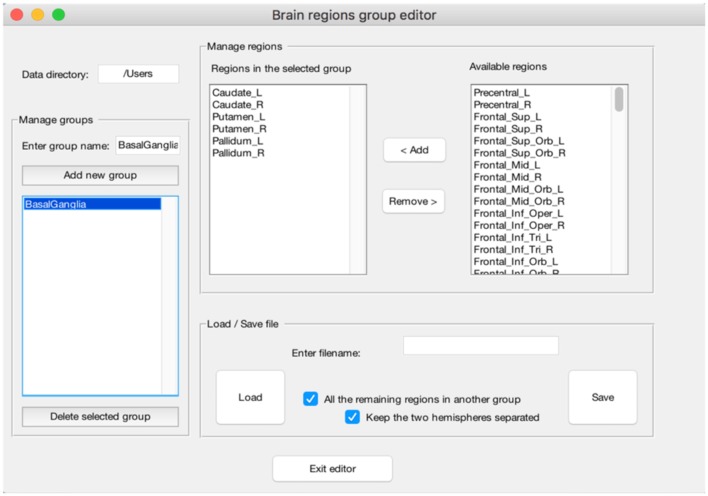
Example of the “Peaks Segregation” function. The CluB's “Peaks Segregation” module permits to perform a clustering and statistical inference on pre-defined regions or groups of regions taken from the Automatic Anatomical Labeling template (Rorden and Brett, 2000). In the figure, a new group of brain regions named “BasalGanglia” has been created (left—“Menage groups”). The list of brain regions included in the group is reported in the middle of the figure (mid-left—“Regions in the selected group”), along with the remaining brain regions (mid-right—“Available regions”). This operation will allow CluB to perform the clustering by taking into account the anatomical constraints selected by the user.